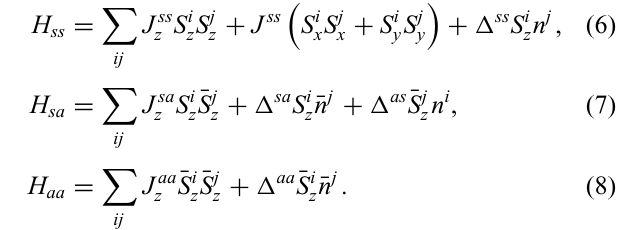
FIG. 5. Local manipulation using LG modes. (a) Overlap of the radial | 59 C (cid:3) wave function (black) with LG 0,1 (red, λ = 532 nm, NA = 0.5). (b) (cid:15) n , n (cid:4) for different wavelengths focused with NA = 0.5: 532 nm (blue), 1064 nm (green), and 1550 nm (red). The filled symbols show n (cid:4) = n + 2 transitions driven by interfering LG 0, − 1 and LG 0,1 modes, while the open symbols show n (cid:4) = n + 3 transitions driven by interfering LG 0, − 1 and LG 0,2 modes. The corresponding lines show the approximation of Eq.